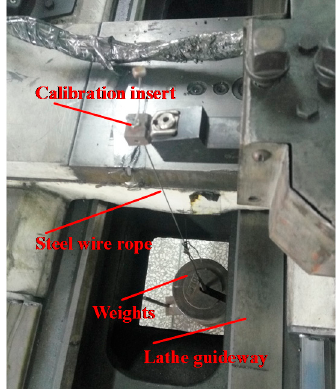
Metals 2019 , 9 , x FOR PEER REVIEW Figure 4. Calibration of measuring force system. Figure 4. Calibration of measuring force system. Figure 4. Calibration of measuring force system.